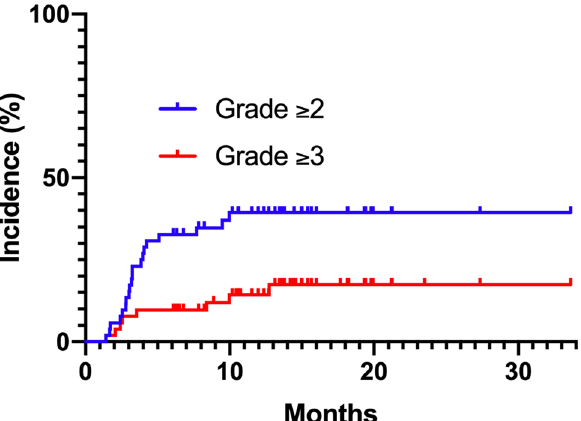
Figure 1. The cumulative incidences of grade ≥ 2 and ≥ 3 radiation pneumonitis (RP). The cumulative incidences of grade ≥ 2 RP were 32.7 and 39.3% at 6 and 12 months, respectively. The cumulative incidences of grade ≥ 3 RP were 9.6 and 14.3% at 6 and 12 months,